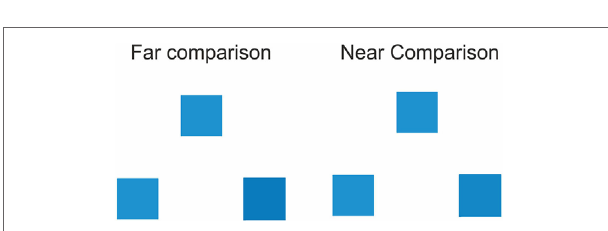
FigUre 2 | Examples of far (left) and near (right) comparison